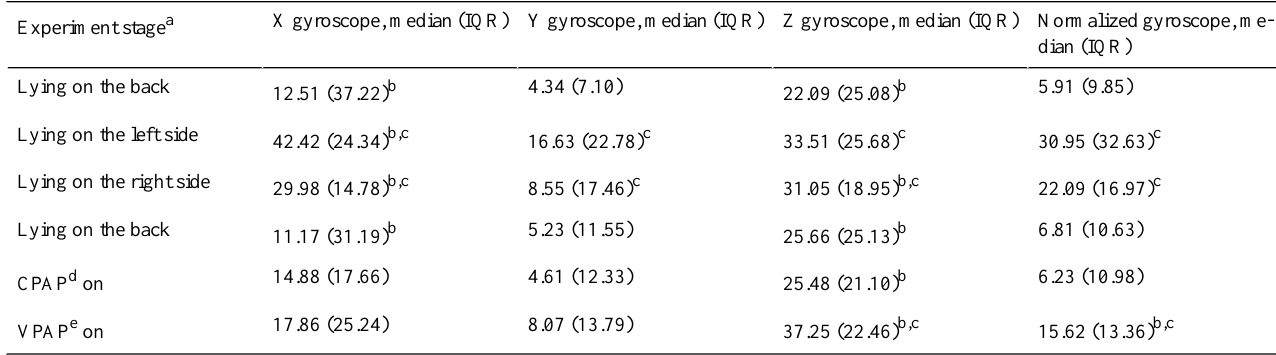
Table 3. Median (IQR) percentage of heartbeats that were incorrectly classified as heartbeats by the heartbeat detection algorithm.